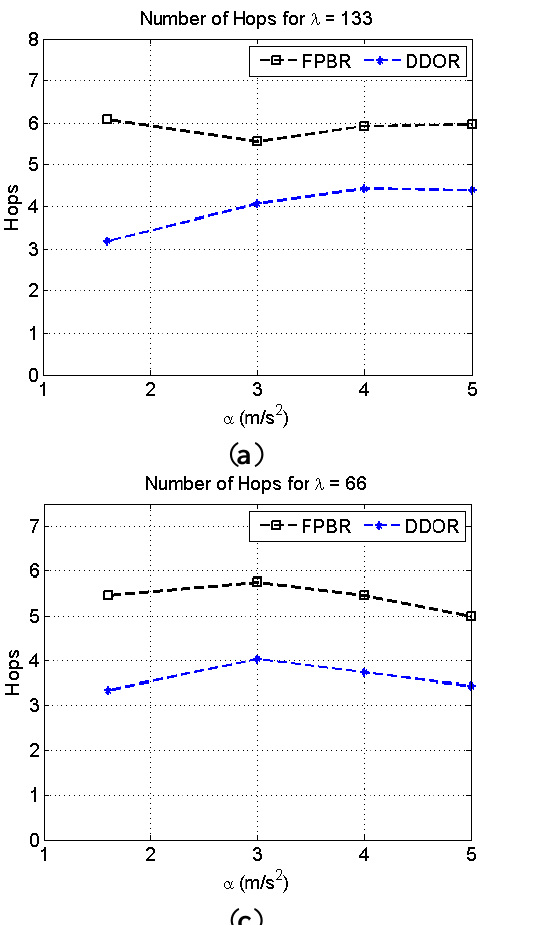
Figure 12. Average number of hops obtained with FPBR and DDOR when increasing the maximum